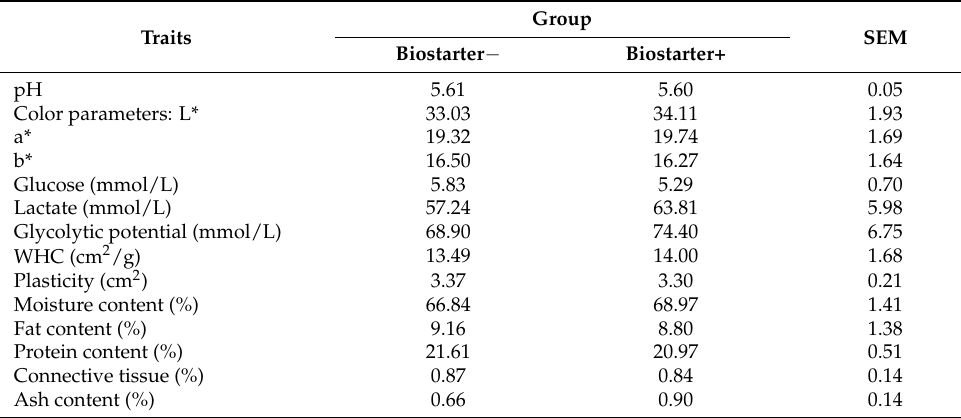
Figure 2. Changes of pH during aging. Average values with standard deviation bars are shown. Table 2. Characteristics of beef quality after dry-aging.